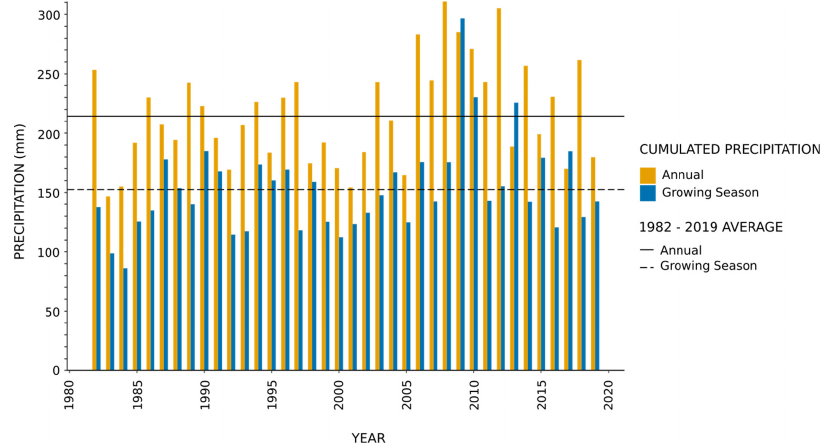
Figure 3. Evolution of precipitation (mm) from 1982 to 2019 over the Oriental. Bars = cumulated precipitation over the year and the growing season (growing season i = September of year i − 1 to March of year i). Lines = 1982–2019 average for annual and growing season precipitation. Data: CHIRPS v2.0 [84]. (See Figure S2 for a black and white version.).